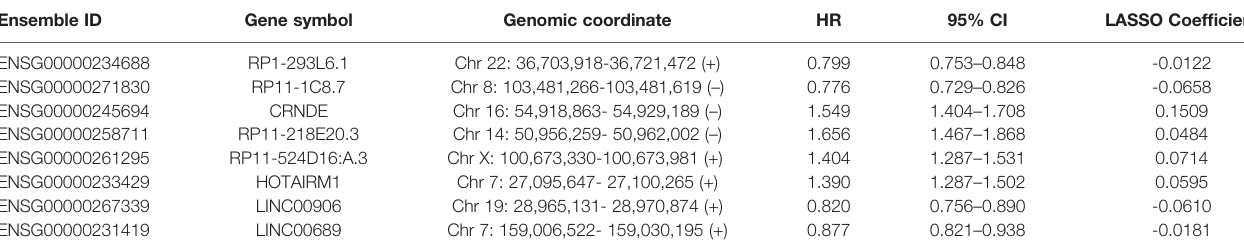
TABLE 1 | The signi fi cant lncRNAs associated with overall survival in LASSO penalized regression. Ensemble ID Gene symbol Genomic coordinate HR 95% CI LASSO Coef fi cient